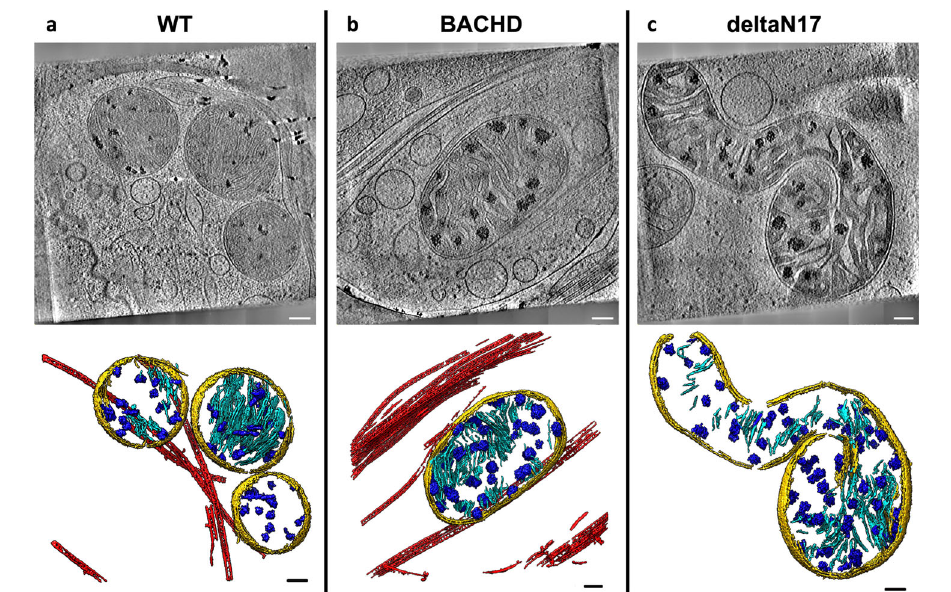
Fig.3|MitochondriafromneuritesofHDmousemodelneuronsexhibitaltered morphologyandcontainenlargedgranulesofvaryingsize. Slices(~1.4nmthick) through selected regions of representative cryoET tomograms and corresponding segmentations of local features for a WT, b BACHD and c dN17 BACHD primary